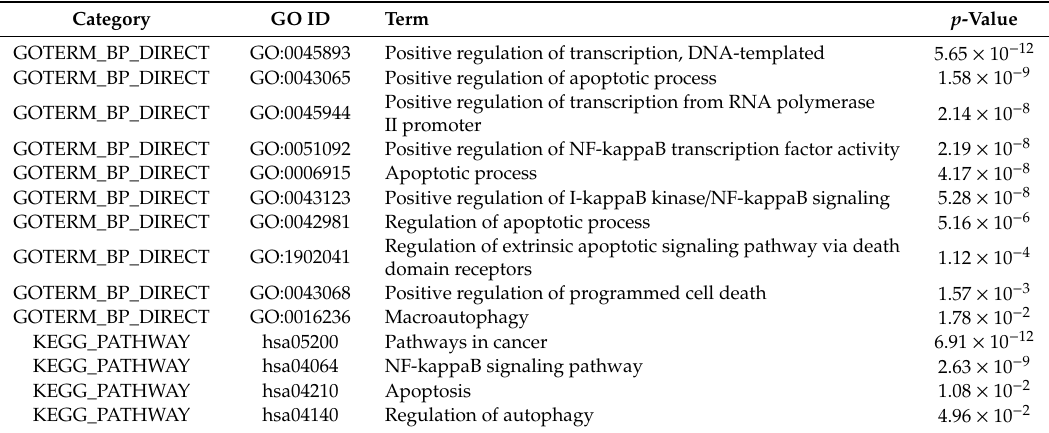
Table 1. Transcriptomic analysis of HOXA9-regulated genes by RNA-Seq in cutaneous squamous cell carcinoma (cSCC) cells. Over-represented categories by GO (Gene Ontology) and KEGG (Kyoto Encyclopedia of Genes and Genomes) pathway analysis of di ff erently-expressed genes. BP: biological process. The “NF-kappaB signaling pathway”, “Apoptosis” and “Regulation of autophagy” were